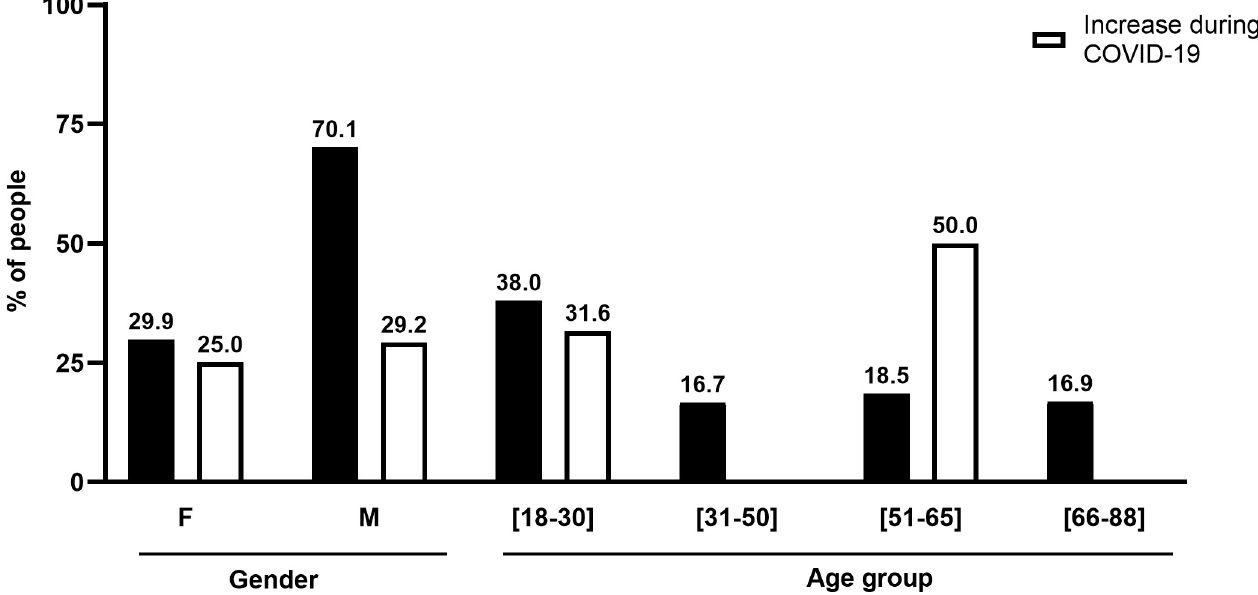
Fig 4. Characterisation of the Portuguese population consuming illegal substances. The black bars correspond to the usual consumption of illegal substances, while the white bars refer to the increase of illegal substances consumption during the COVID-19 pandemic. The Y axis represents the percentage (%) of people; the individual values are above each bar. The analysis by group (gender: female (F) and male (M) and age group) is represented in the X